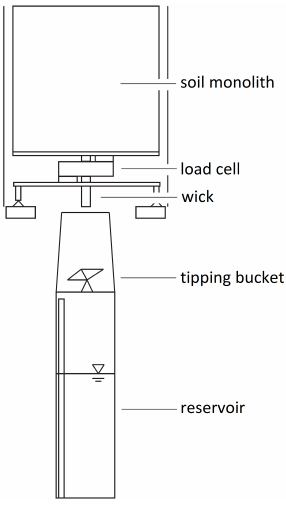
Figure 4. Lysimeter